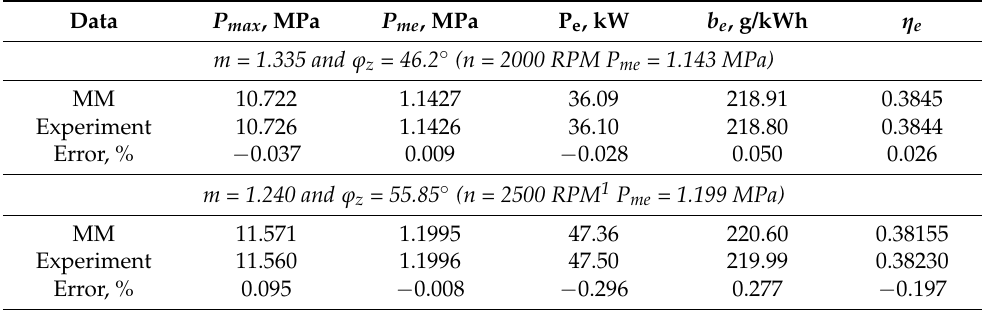
Table 4. Comparison between simulated engine work parameters and experimental results.